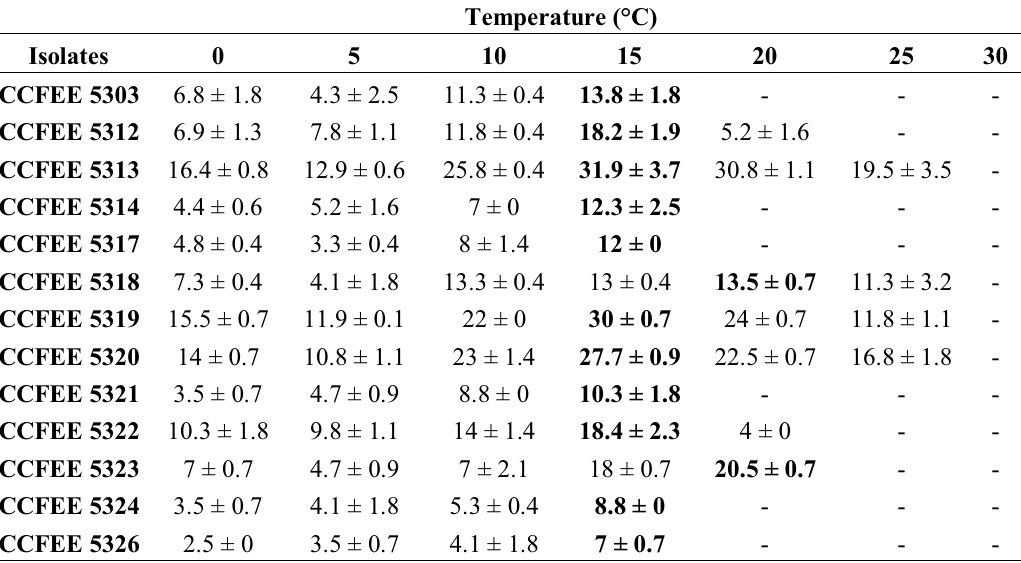
Table 3. Temperature